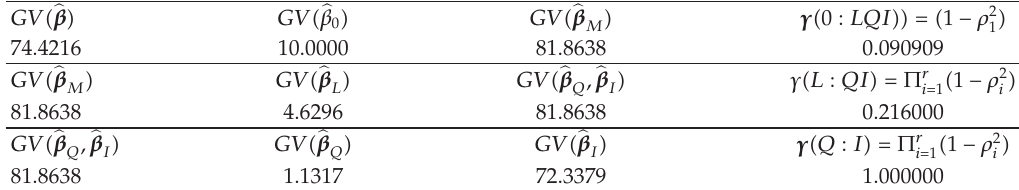
Table 4: Generalized variances and Vector Alienation Coe ffi cients between designated subsets for Hartley’s (cid:7) 39 (cid:8) SCD in k (cid:3) 3